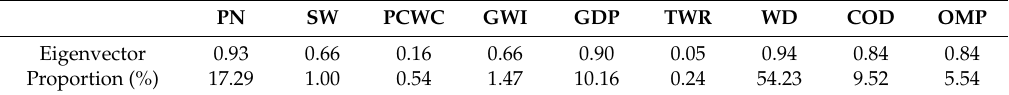
Table 5. Eigenvectors of PCR in all